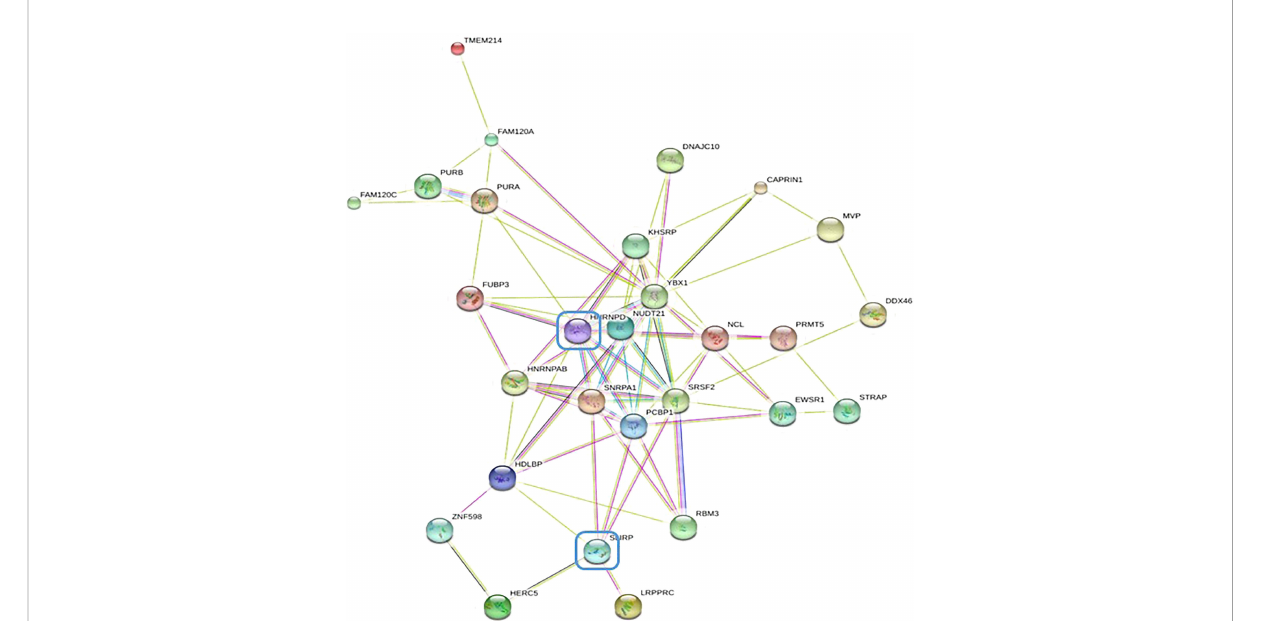
FIGURE 4 STRING database protein – protein interaction network diagram of differentially expressed genes by mass